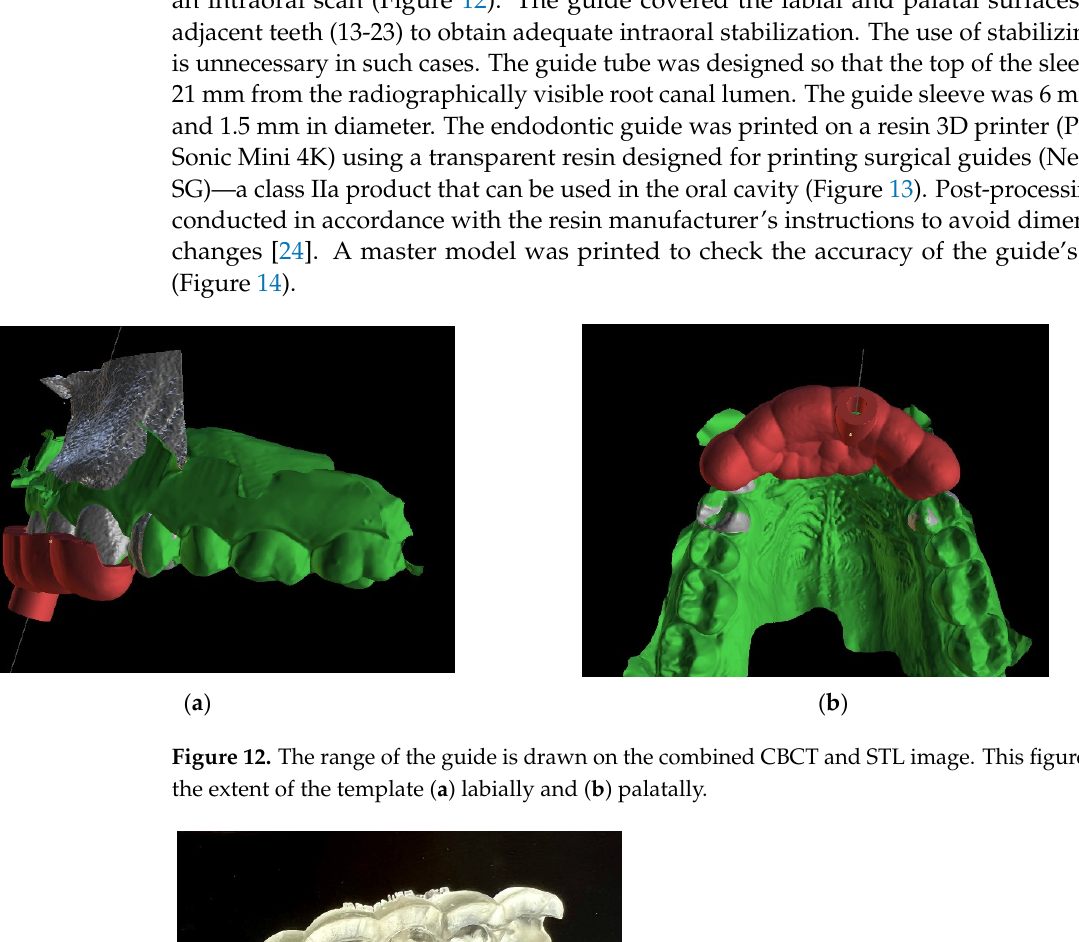
Figure 11. CBCT image presenting a scheduled virtual implant: endodontic access path in ( a ) sagittal view and ( b ) coronal view. The volume of the preserved dentin around the access path is shown.